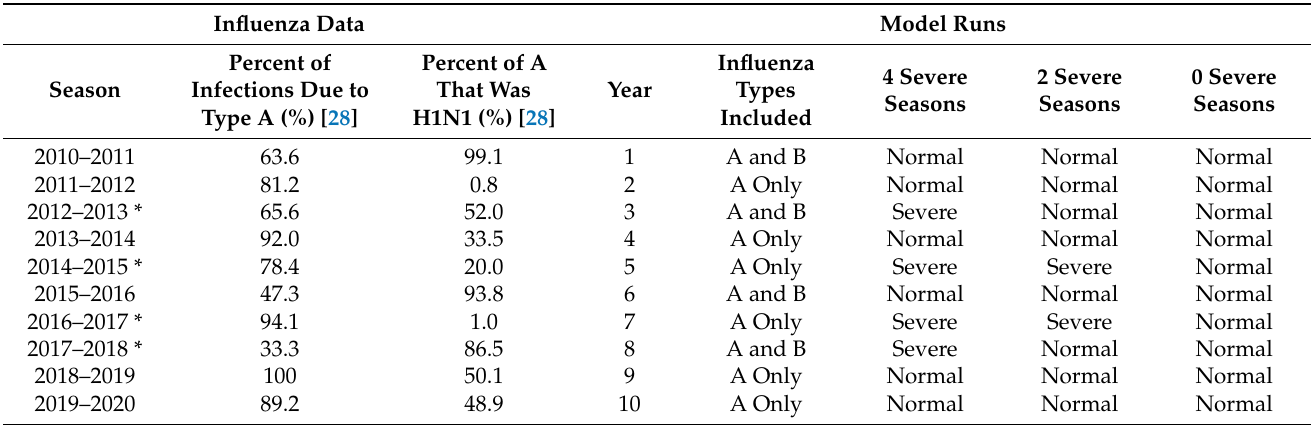
Table 1. Characteristics of the influenza seasons for the base case